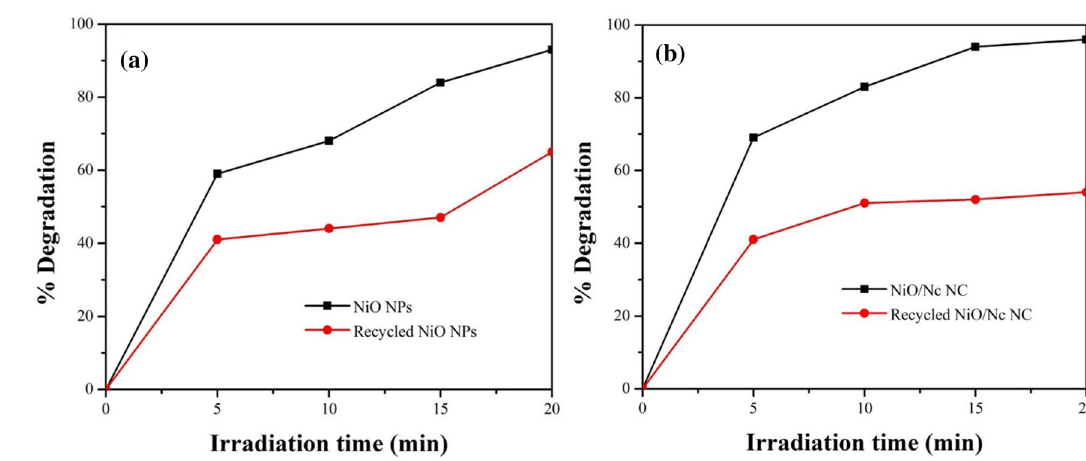
Fig. 7 Comparison of %degradation of O II dye photodegraded by fresh and recycled a NiO NPs b NiO/Nc